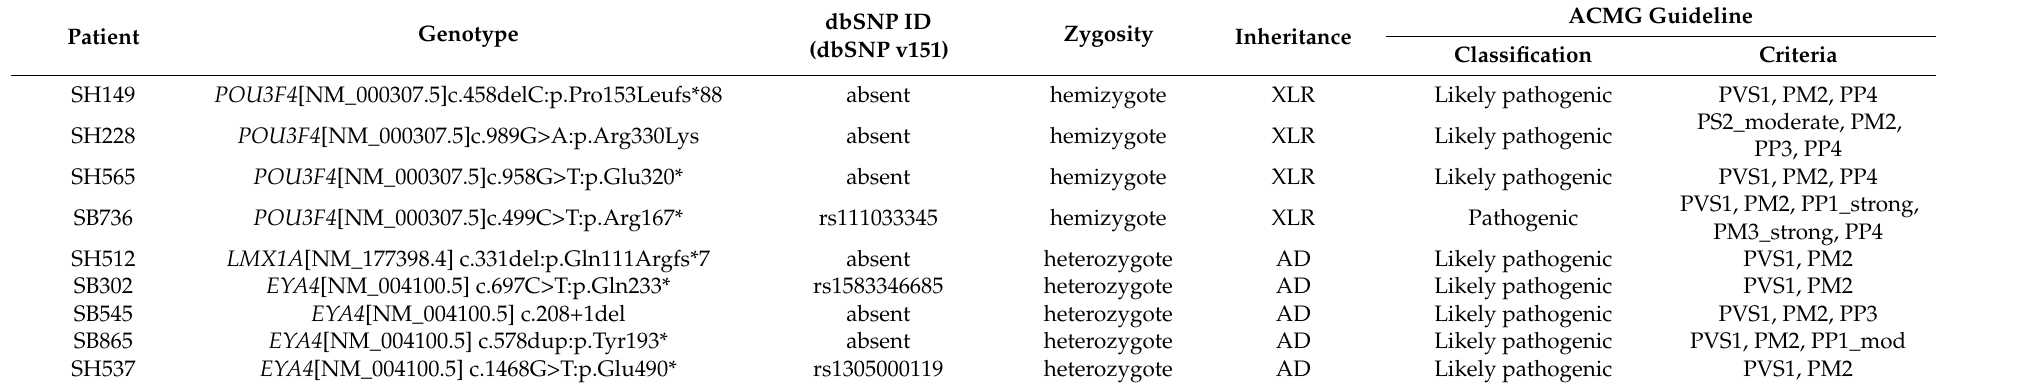
Table 2. Novel variants of transcription factor genes associated with non-syndromic